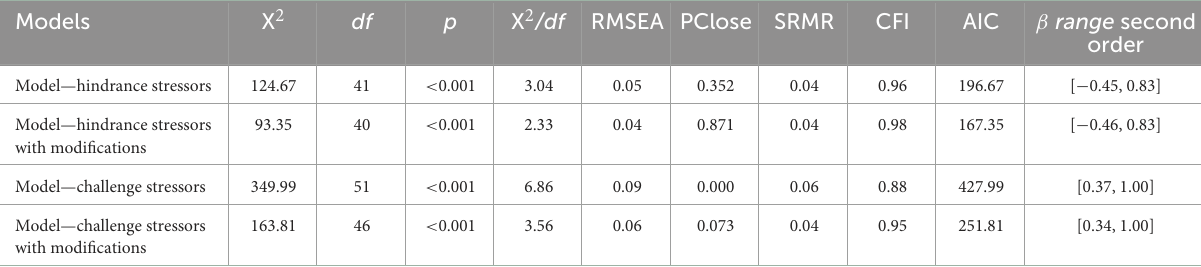
TABLE 1 Model adequacy and goodness of fit indices of the models tested using first- and second-order confirmatory factor analysis. Models